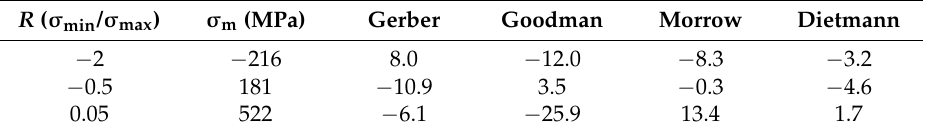
Figure 10. Haigh diagram with the empirical lines of Gerber [18], Goodman [23], Morrow [24] and Dietmann [28] and the experimental results at 2 × 10 6 cycles. Table 4. Relative errors (%) of the different theories: Gerber [18], Goodman [23], Morrow [24] and Dietmann [28] for N = 2 × 10 6 cycles. Positive values mean conservative results predicted by the theory, negative values non-conservative